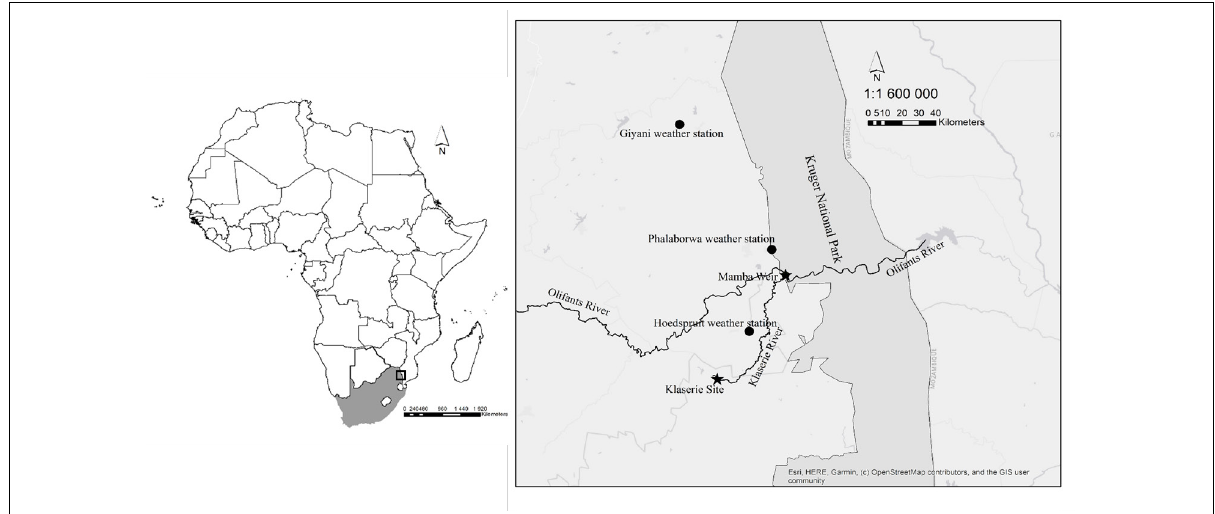
Figure 1: Map of study site (with an insert of Africa highlighting South Africa) showing Mamba Weir in the lower Olifants River in Kruger National Park, Limpopo Province; the Klaserie site in the upper Klaserie River, Mpumalanga Province; and three weather stations (Hoedspruit, Phalaborwa and Giyani), across Limpopo Province; and where air temperature measurements were taken for the